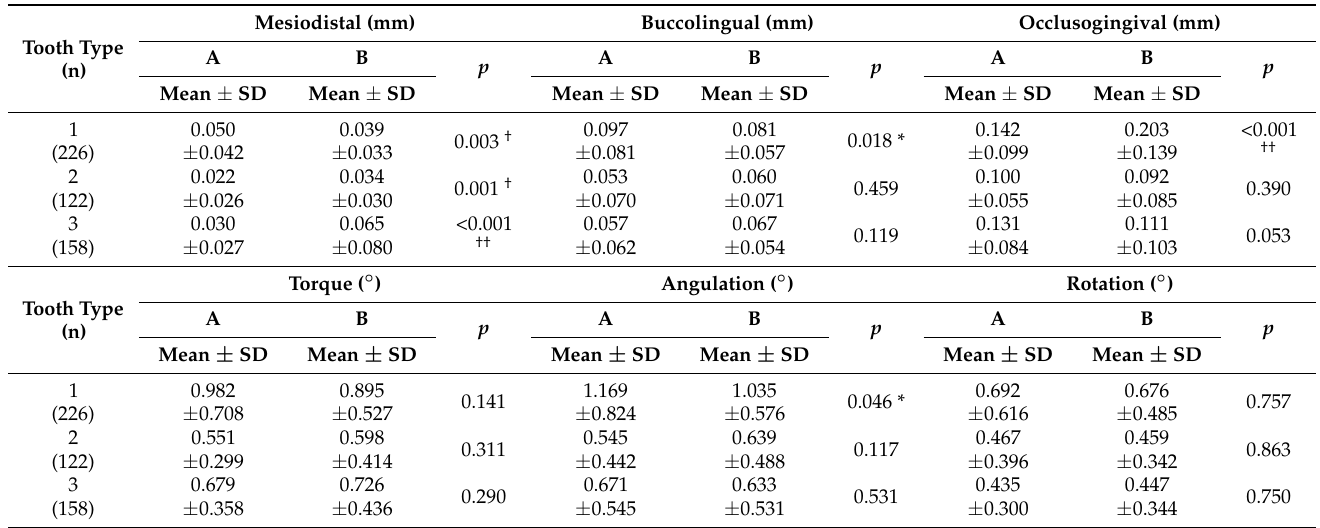
Mean, mean value of difference; SD, standard deviation. n is number of brackets used for analysis. Independent t -test was performed for calculating p value. * p < 0.05; † p < 0.01; †† p < 0.001. Tooth type 1, 2, and 3 represent six anterior teeth, premolars, and molars, respectively. Group A is the experimental group with resin base formed in advance, and group 2 is the group without resin